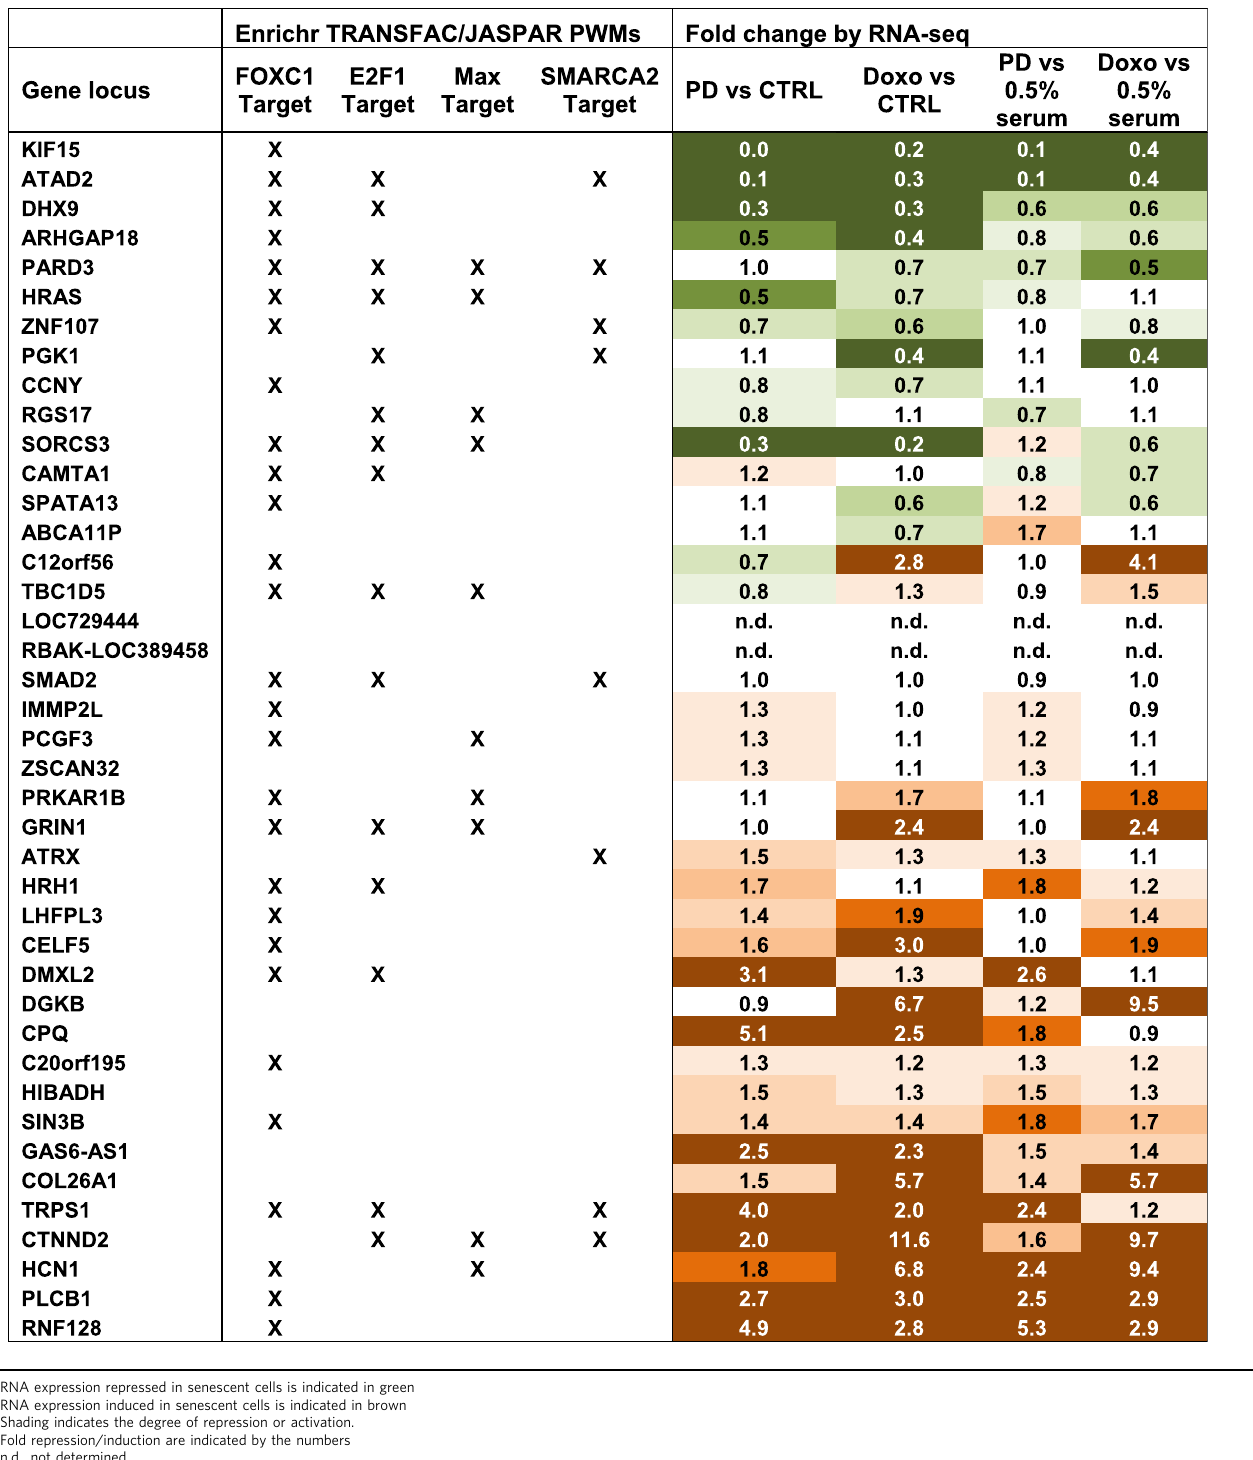
Table 1 RNA expression of genes bound by ATRX in senescent cells